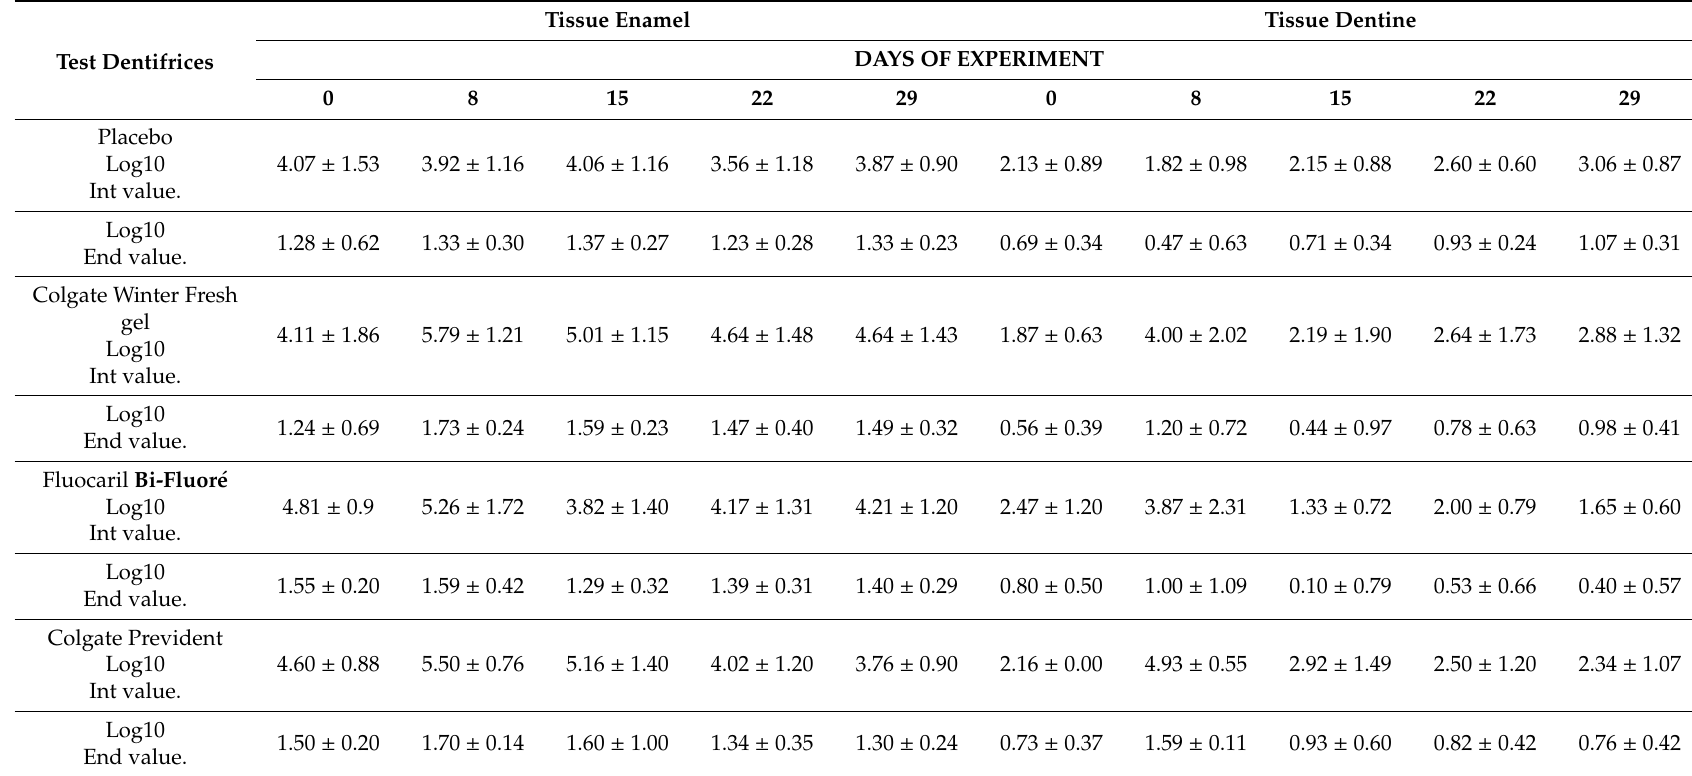
Table 1. Peak electrical resistance of enamel and dentine during the